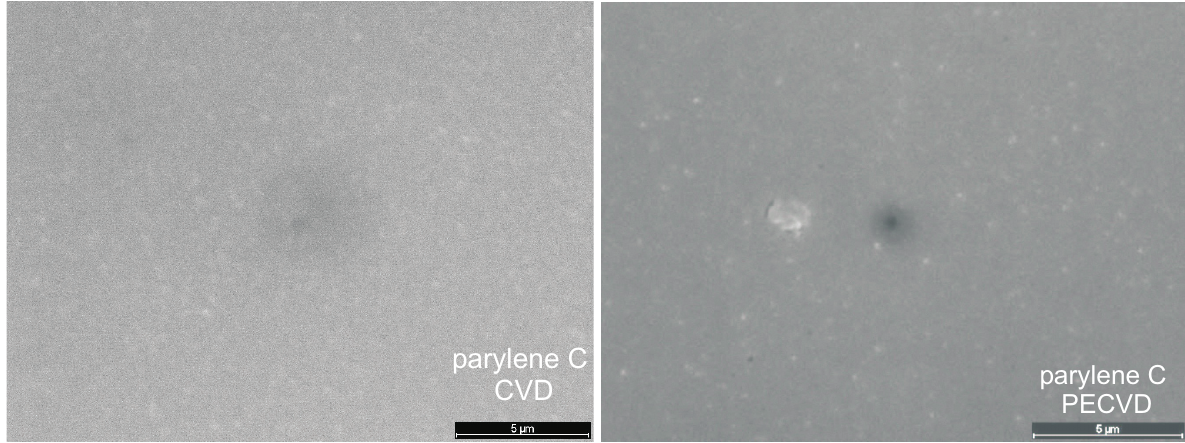
Figure 26. Micrographs of parylene C (CVD, LHS) and parylene C (PECVD, RHS), scaling bar is 5 µ m. The surface energy of the films of the N-derivate is at the low-pressure limit of the chlorine-derivate. Other groups report contact angles against water of 90–103 ◦ for parylene C [17,74–77] and 81–87 ◦ for parylene N, resp. [77,78]. So their windows are very narrow compared to the widths obtained in this